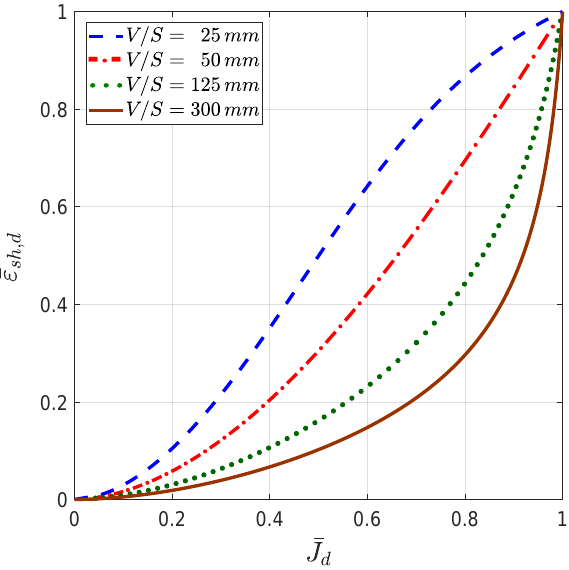
Figure 8. The influence of different V/S ratios on the drying creep vs. drying shrinkage kinetics according to the fib MC 2010 model. The remaining parameters are from the first line in Tab.